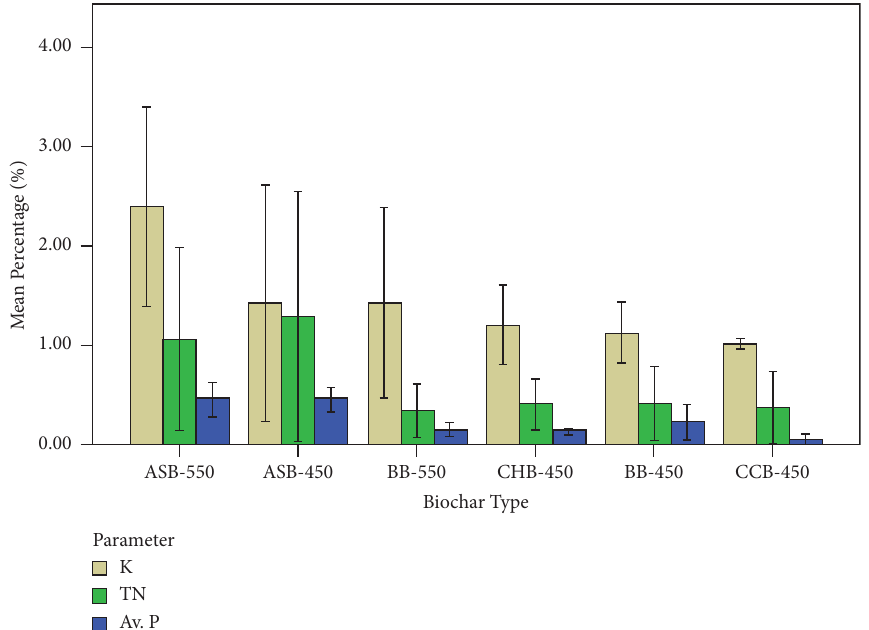
Figure 7: Efect of pyrolysis temperature and feedstock type on biochar macronutrient